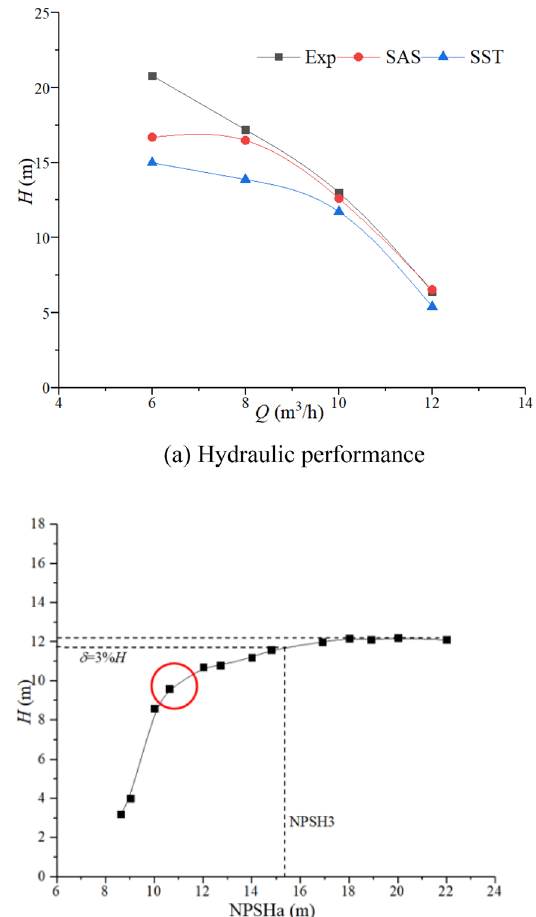
Figure 5 Performance curves of side channel pump.